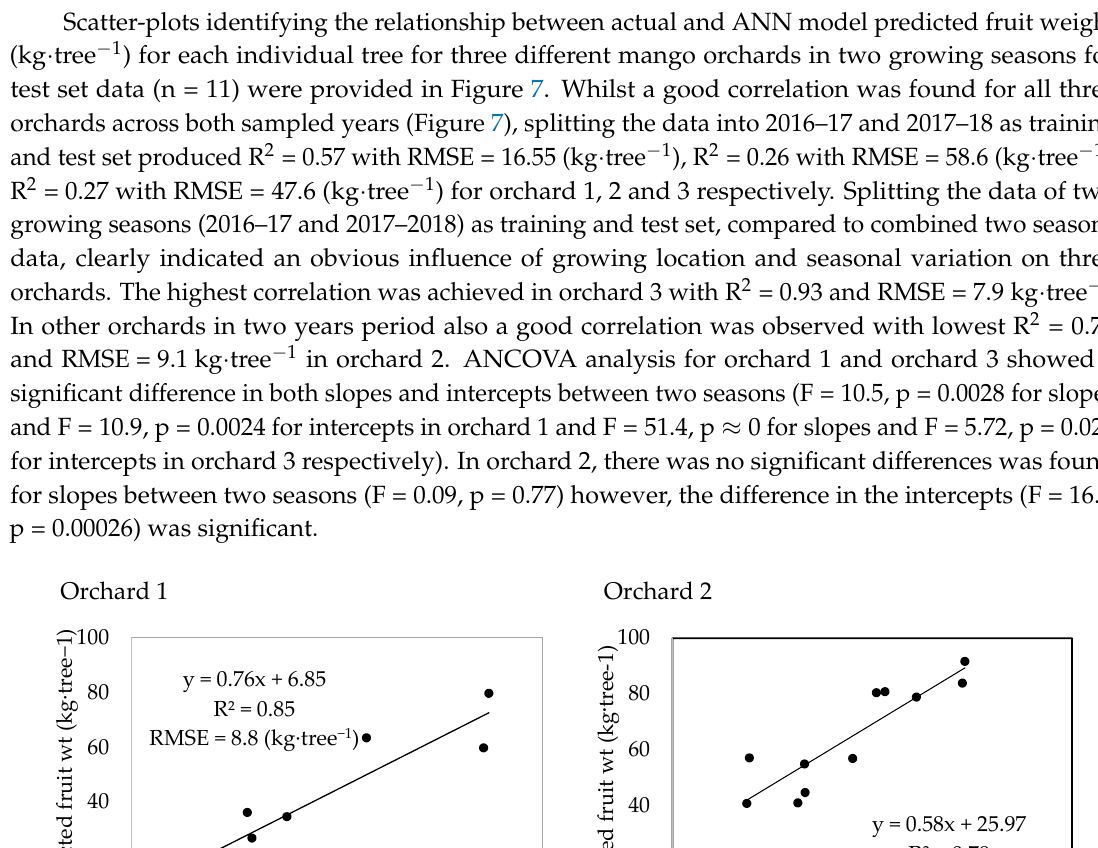
Figure 6. The correlation between actual and predicted total fruit weight (kg · tree − 1 ) ( Left ) and fruit number with combined VIs and TCA from test set data ( Right ) (n = 33 from three orchards).